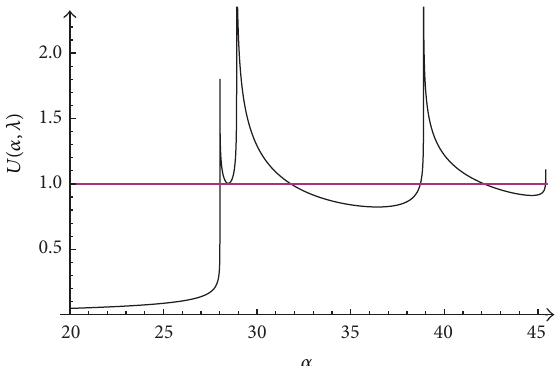
Figure 12: Four solutions of problem (15), (10), 𝛼 ≈ 25.3608 , 𝛼 ≈ 30.0365 , 𝛼 ≈ 34.7552 , and 𝛼 ≈ 41.4674 .